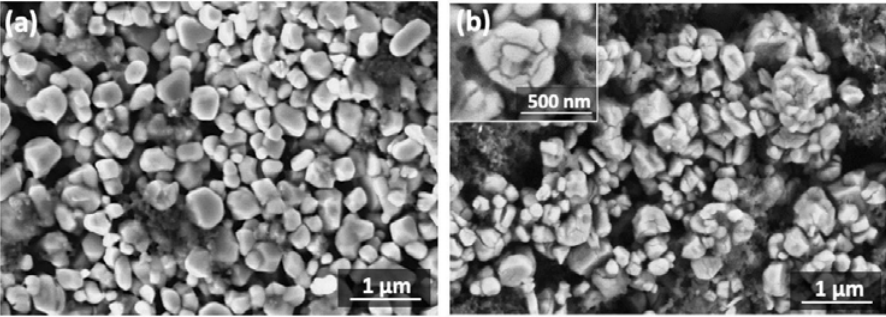
Figure 10. SEM images of the pristine ( a ) and cycled 330 times ( b ) MW_60m_A NMC811 electrodes. The magnified SEM image of the cracked particle after 330 cycles is provided in the inset.